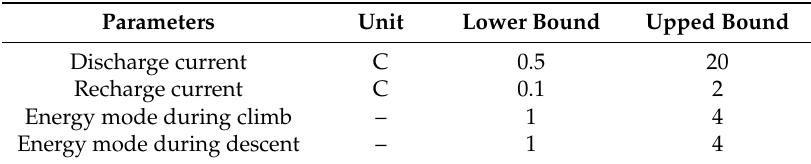
Table 5. Design variables related to the energy management strategy.